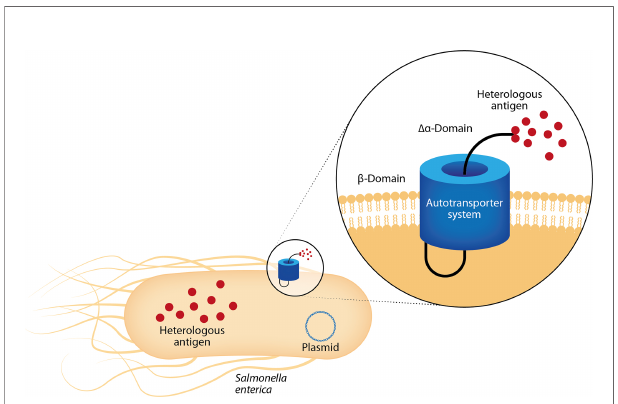
FIGURE 5 | Mucosal vaccines with bacterial replication vectors: Salmonella enterica as delivery system. After mucosal administration, live-attenuated S. enterica colonize lymphoid tissues and remain there, serving as factories that continuously synthesize and deliver heterologous antigens. These bacteria show tropism for antigen-presenting cells, allowing the induction of mucosal and systemic immune responses. They successfully carry heterologous antigens, as genes and proteins, in the cytosol or can display them on its surface through autotransporter systems as MisL protein. The sequence encoding the MisL a -domain is genetically modi fi ed to add the sequence encoding the heterologous